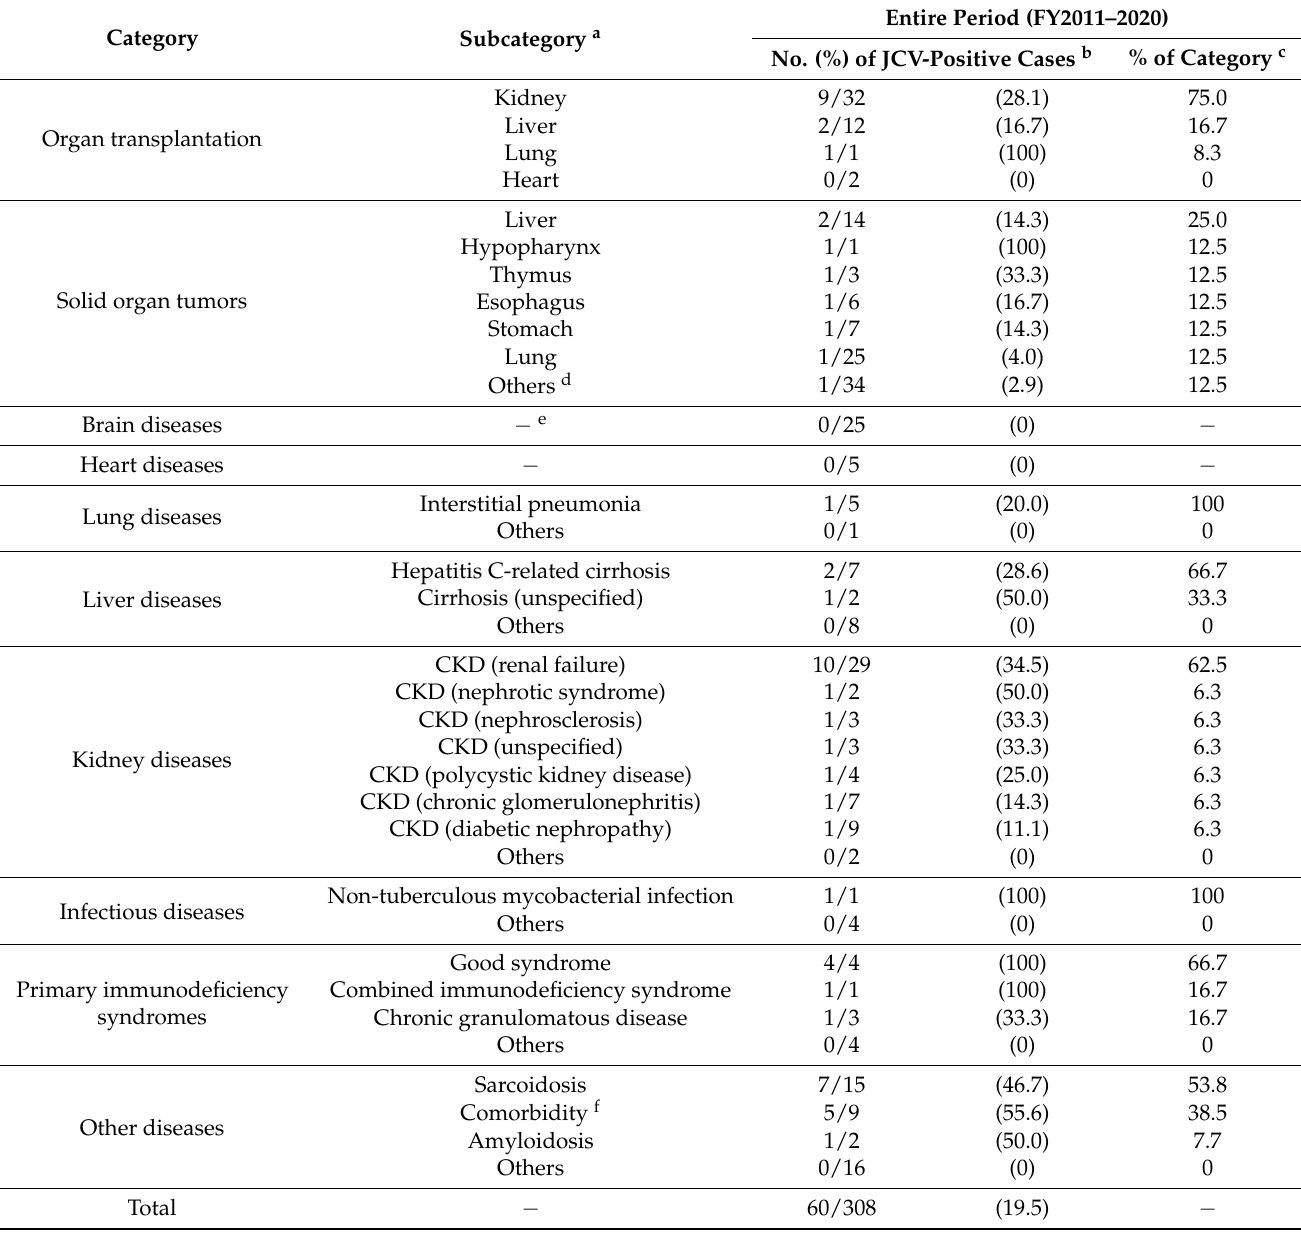
Table 5. PCR-based detection of JCV in CSF specimens from patients with organ transplantation, solid cancers, and other